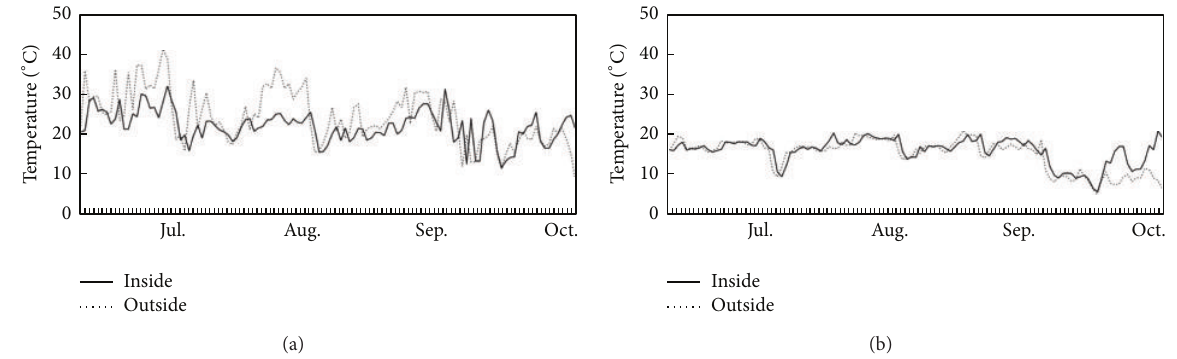
Figure 3: Daily maximum (a) and minimum (b) air temperature near the ground from late June to October, 2011, inside and outside the deer exclosure in Okutama, western Tokyo, Japan.